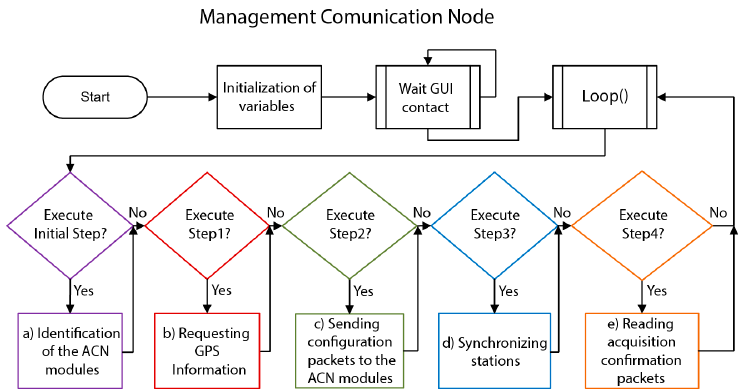
Figure 7. General flowchart of the MCN software.